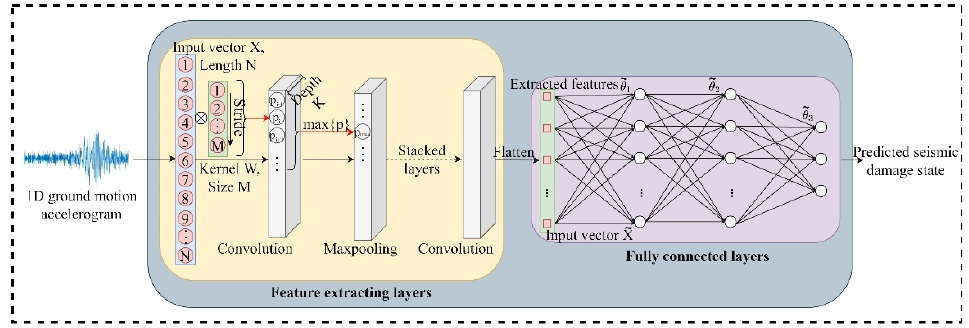
Figure 2. The architecture of 1D CNNs with the feature extracting (convolutional and max-pooling) layers and the fully connected layers (the FNN